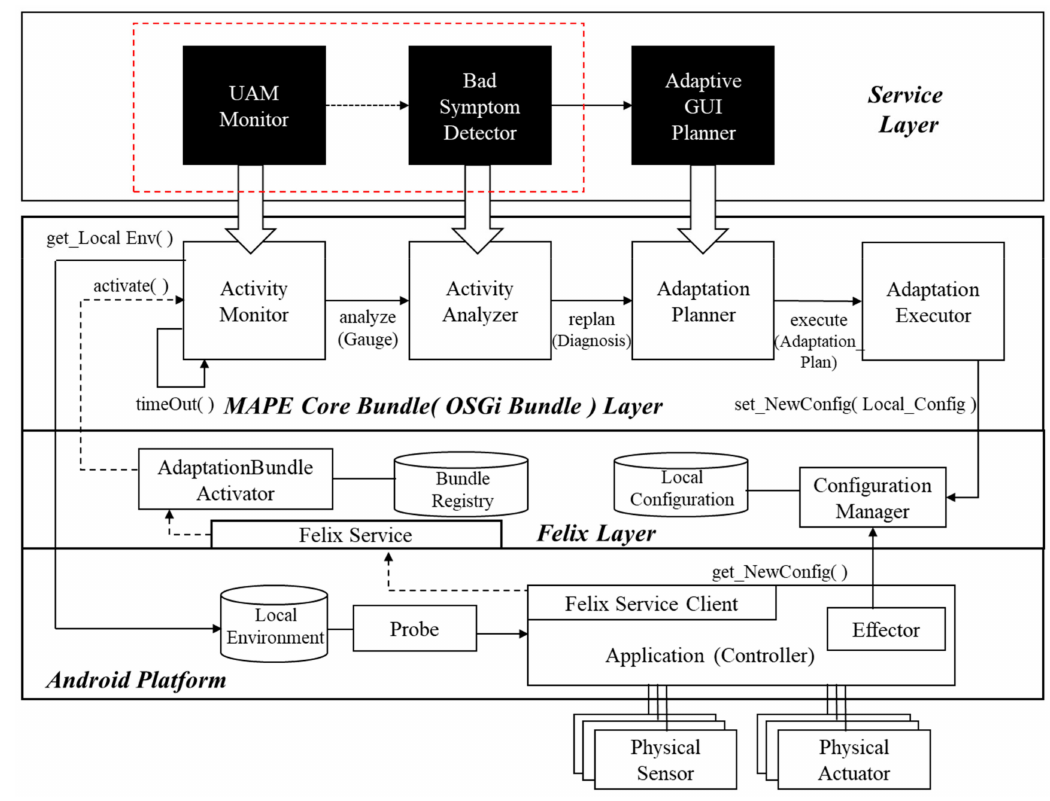
Figure 1. A self-adaptive framework for automatic user activity